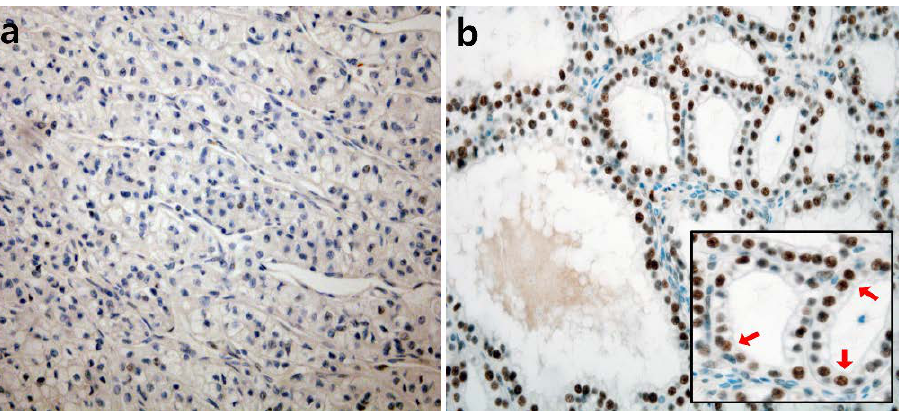
Figure 1. Representative photomicrographs of immunohistochemical staining for DUSP4 in clear cell RCC (( a ): negative, ( b ): positive, × 400). Nuclei of tumor cells clearly showing brown color were considered as positive staining (indicated by red